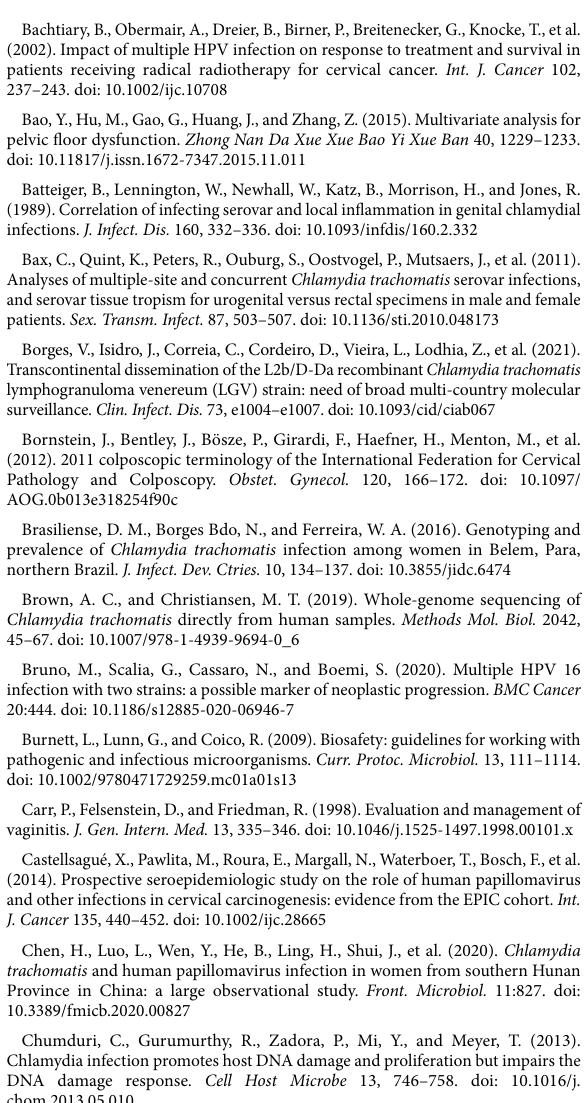
SUPPLEMENTARY FIGURE S1 Reference sequences alignment and primers design for next generation high-throughput sequencing (NGHTS) targets. SUPPLEMENTARY FIGURE S2 The schematic diagram of the identification of Chlamydia trachomatis ( C. trachomatis ) mixed-genotype infection using the next generation high- throughput sequencing (NGHTS) process. PCR, polymerase chain reaction; BWA, Burrows-Wheeler transform. SUPPLEMENTARY FIGURE S3 Low detection limit of high-throughput sequencing primers for different Chlamydia trachomatis genotypes. SUPPLEMENTARY FIGURE S4 Verification of genotype-specific primers for amplifying minor Chlamydia trachomatis ( C. trachomatis ) genotypes from mixed-genotype infections of C. trachomatis . (A) Genotype-specific primers can specifically amplify minor C. trachomatis genotypes when using plasmid DNAs of mixed- genotypes of C. trachomatis as templates. (B) The minor genotypes were specifically amplified from the samples of mixed-genotype infections by using genotype-specific primers. NC, negative control; +, PCR positive; -, PCR